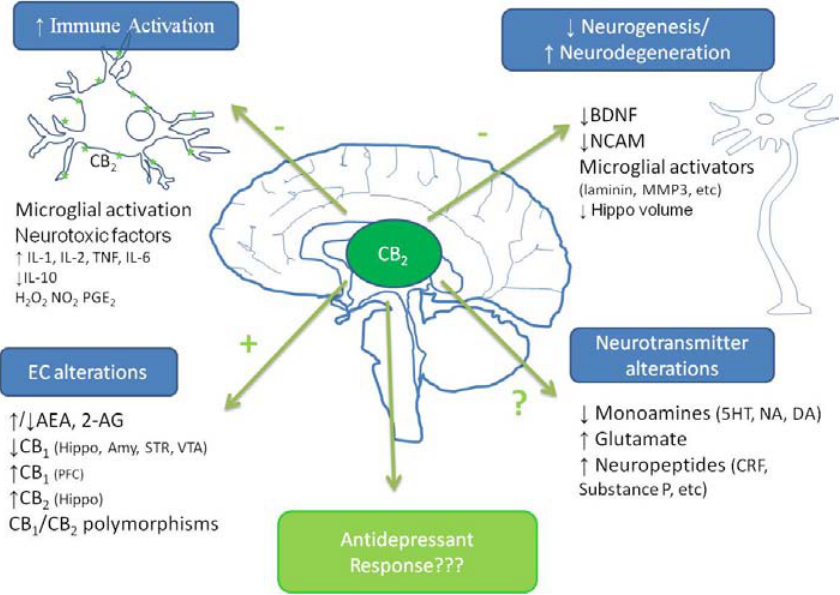
Figure 2. Putative mechanisms underpinning potential antidepressant effect of CB receptor